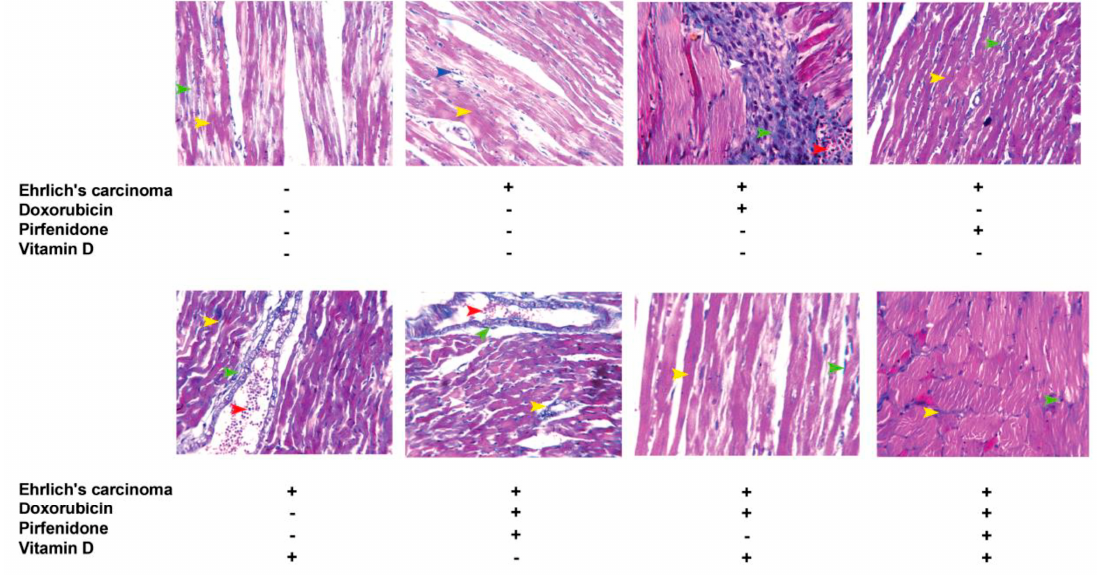
Figure 5. Representative photomicrographs for sections from the heart showing the effect of individual treatment with doxorubicin (15 mg/kg; i.p.), pirfenidone (500 mg/kg; p.o.) or vitamin D (0.5 μ g/kg; i.p.) and their combinations on cardiac tissues fibrosis assessed by Masson trichrome staining in EAC bearing mice on day 21.